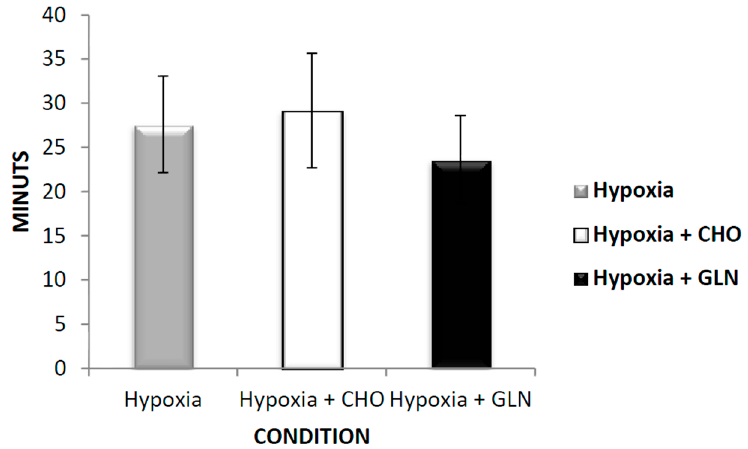
Figure 2. The results of time of exhaustion (min) was described by mean ± Standard Error (SE). The interaction of group versus time was analyzed by Analysis of Variance (ANOVA) for repeated measures followed by post hoc of Tukey test. The level of significance was set at p < 0.05. n = 15